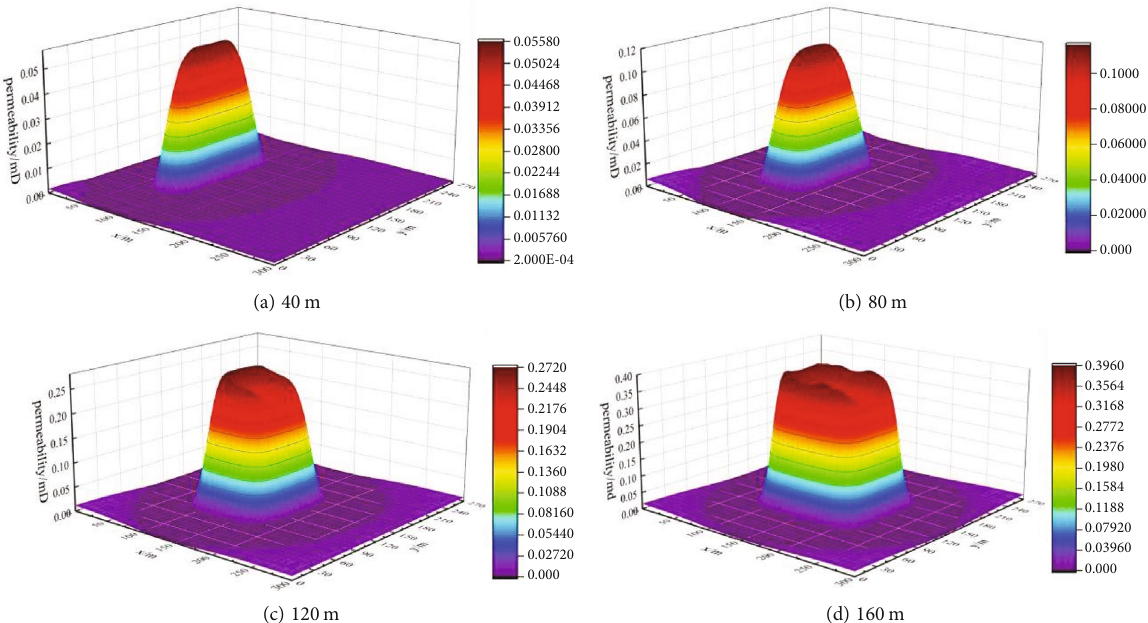
Figure 11: Permeability evolutions of protected layer at di ff erent advancing distances.